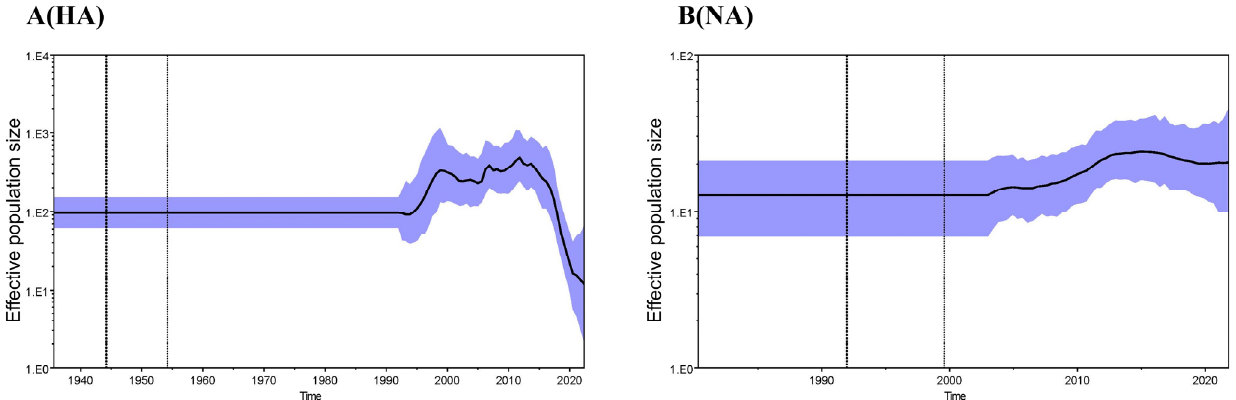
Figure 4. Effective population size of HA and NA. Estimation of effective population size of HA and NA genes of JX 5-1 using the Bayesian SkyGrid model. Panels ( A , B ) represent the HA and NA genes, respectively.